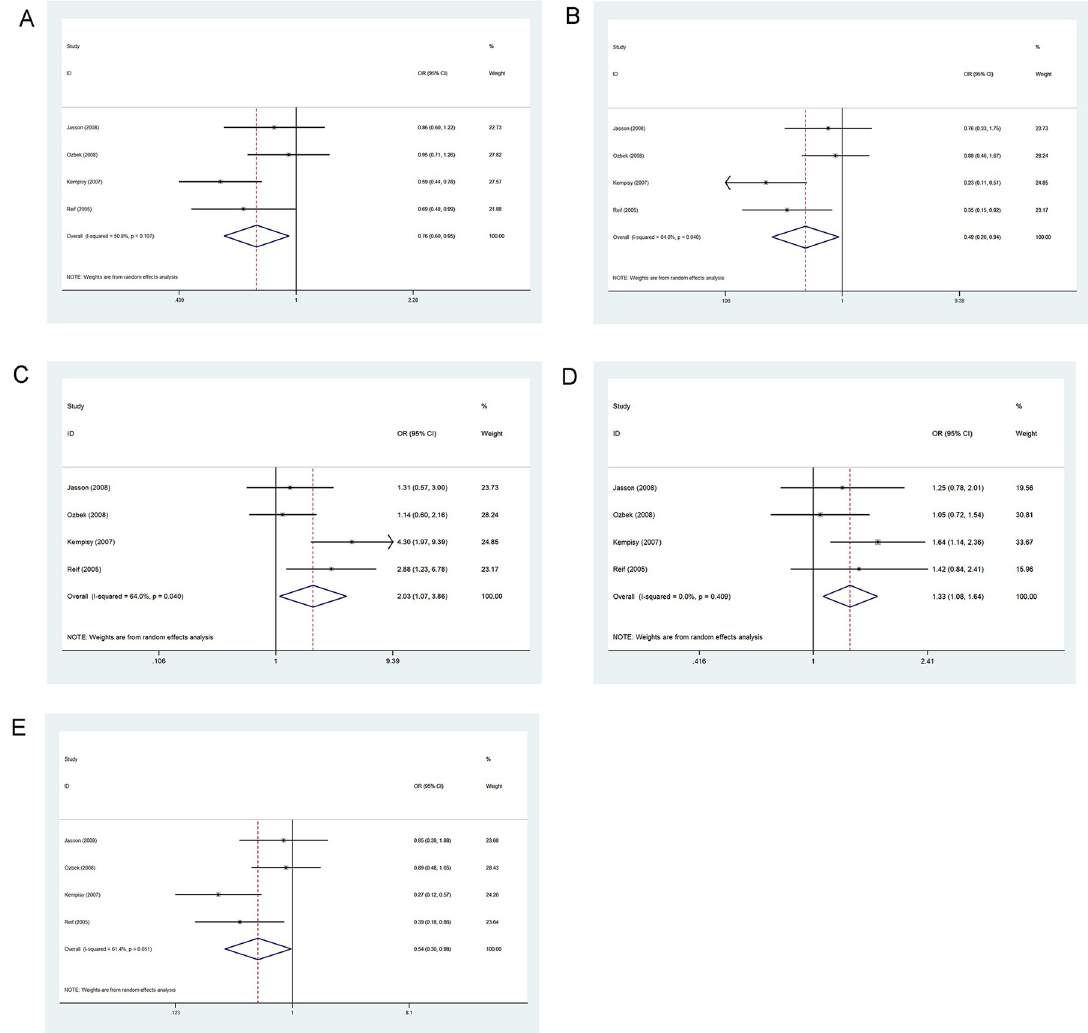
Fig 5. Forest plot of the associations between 1298A > C variation and risk of bipolar disorder in the five genetic models: A, allele contrast; B, homozygous codominant; C, heterozygous codominant; D, dominant; and E, recessive. https://doi.org/10.1371/journal.pone.0271170.g005 Table 7. Summarized ORs with 95% CIs for the association between MTHFR polymorphisms and schizophrenia.